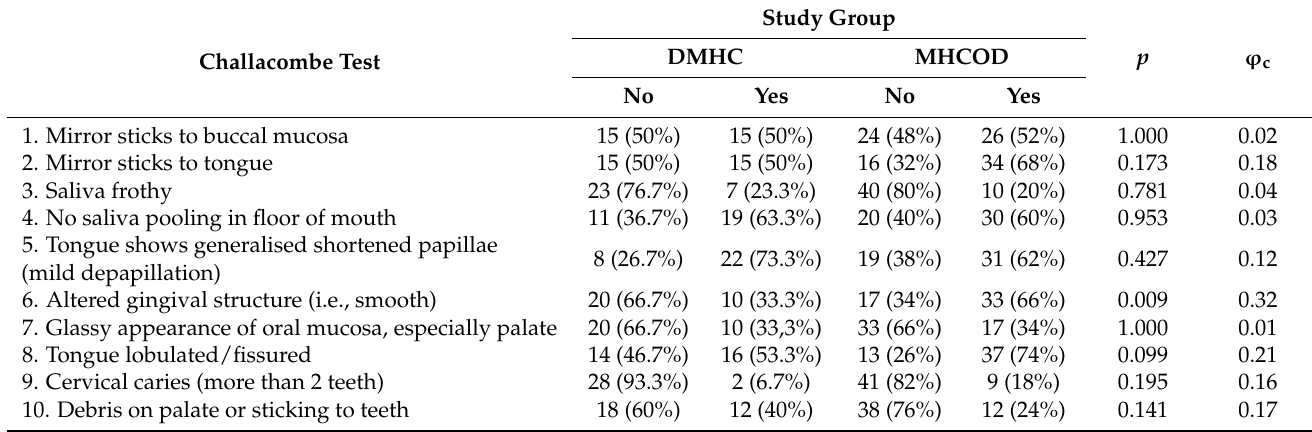
Table 9. The results of Challacombe Test in both groups.